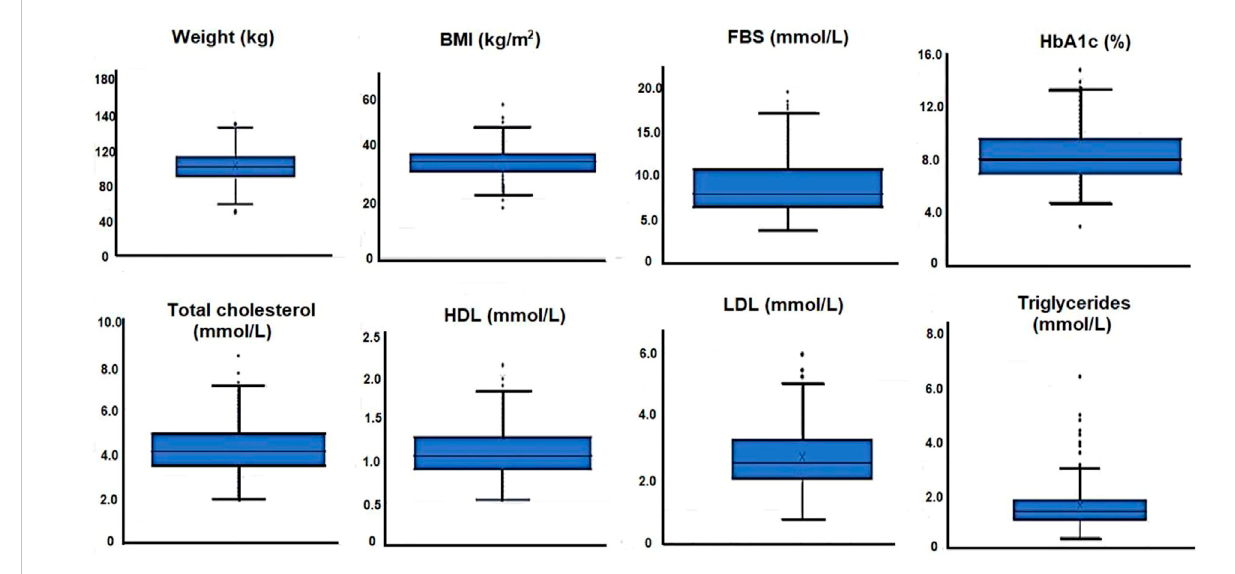
FIGURE 1 Box and whisker plots of baseline anthropometrics and laboratory tests for 434 patients with